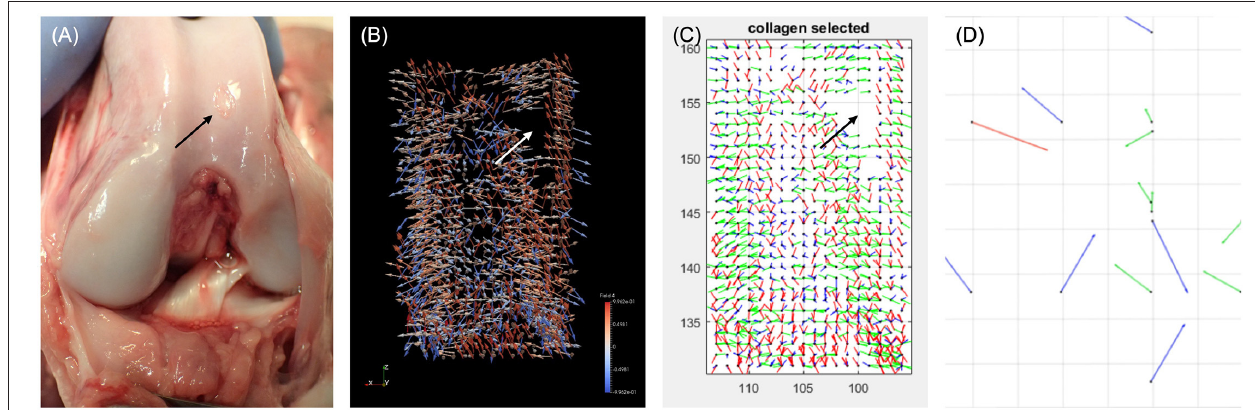
FIGURE 11 | Photograph of a canine stifle at post mortem with the associated collagen tractography using Magic Angle Directional MRI. (A) Photography of canine stifle at post mortem showing a defect in the cartilage (black arrow). (B) Coronal ParaView glyph vector visualization of the collagen fiber orientation following Magic Angle Directional MRI of the femoral condyles showing a signal void (white arrow), consistent with the cartilage defect. (C) Fiber orientation map showing the tractography of the collagen fibers from the same canine stifle, again identifying a signal void (black arrow). (D) Fiber orientation map focusing on the area of signal void, identifying disorganized fiber orientation. Chappell K. Optimisation and visualization of collagen fiber orientation using Magic Angle Directional Imaging (MADI). [PhD Thesis]. 2019. Imperial College London, UK. Reprinted with permission from Dr Karyn